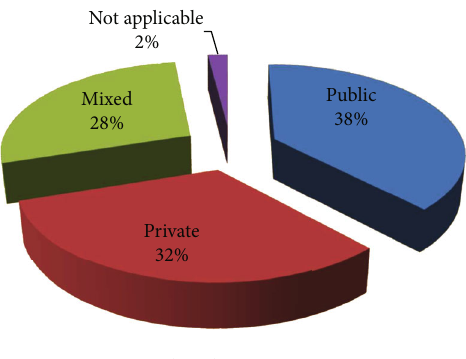
Figure 3: Online consumer behavior studies by nature of organization.